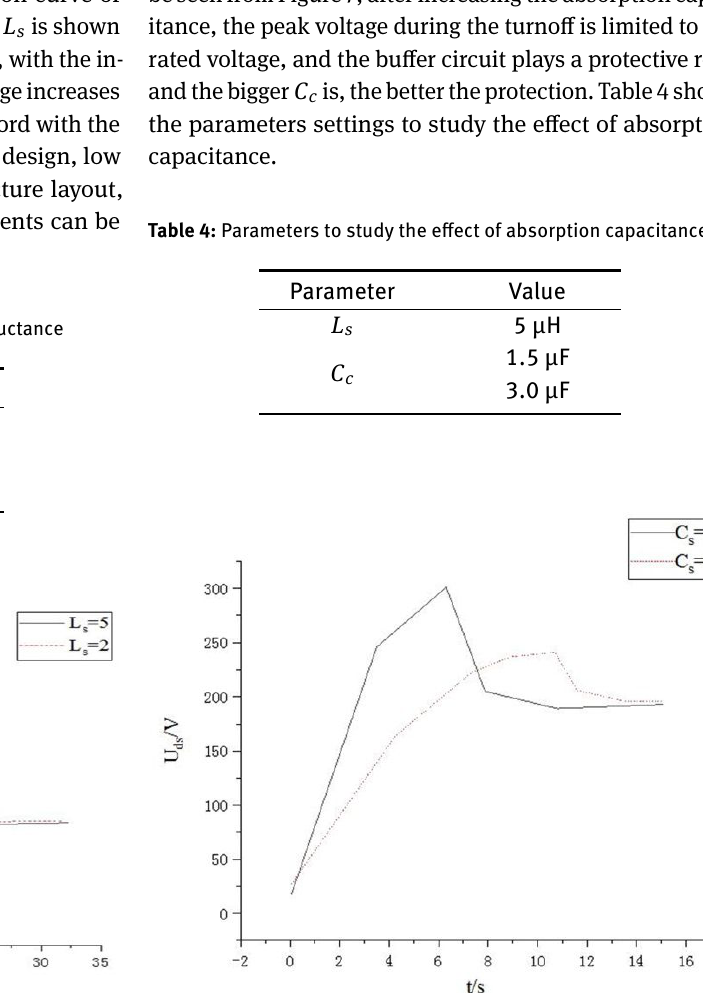
Figure 6: Source-drain voltage U ds simulation curve under different L s